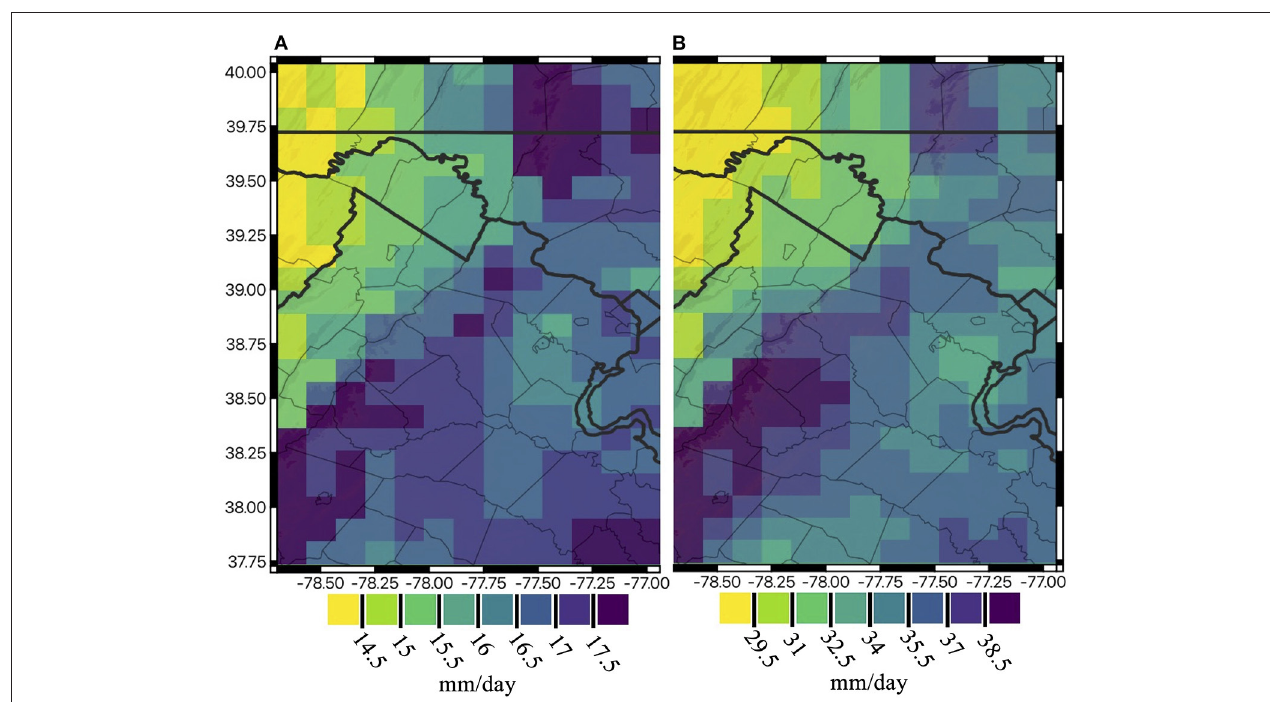
FIGURE 2 | Extreme precipitation magnitudes in mm/day observed during 1980–2018 across the study region represented by the (A) 95 th and (B) 99 th daily total percentiles at each gird point. State boundaries are shown as thick black lines, whereas county boundaries are presented as thinner black lines. Elevations above 500m are also shown in dark brown in the background.